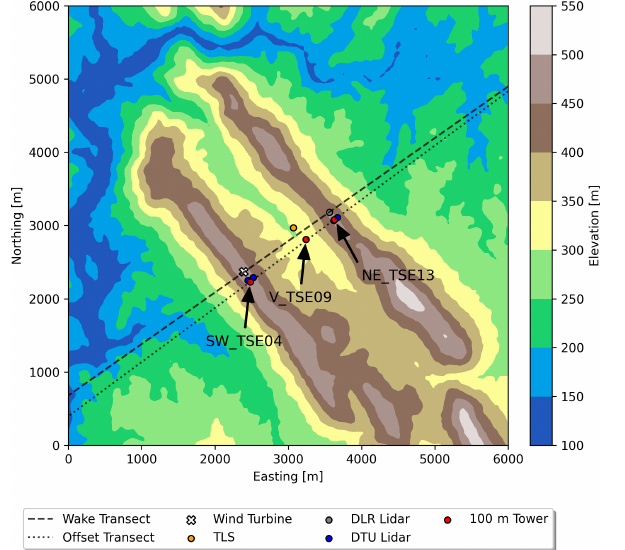
Figure 1. Terrain and layout of the Perdigão site showing the lo- cation of relevant instrumentation. The wake and offset transects are used for analysis later in this paper. Each of the three 100m meteorological towers is labeled following the naming convention in the publicly available dataset corresponding to their geographic